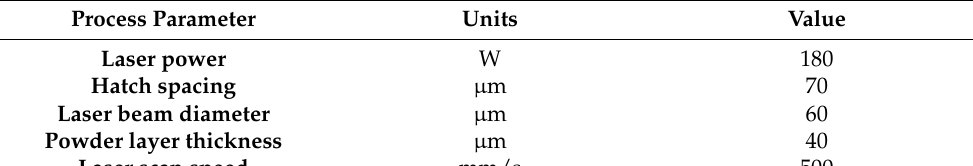
Table 2. Process parameters.